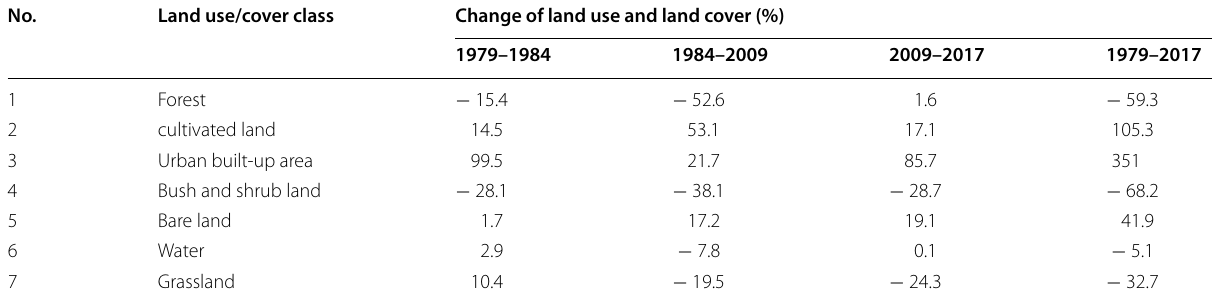
Table 4 Changes of land use and land cover in Huluka Watershed (Percentage) No.